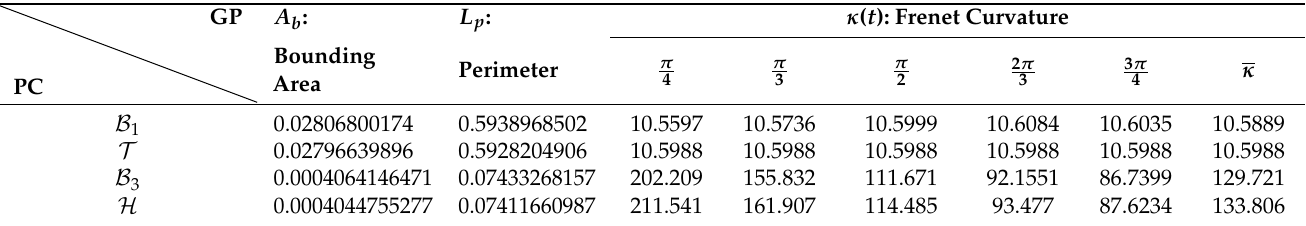
Table 1. Geometric characteristics of Plane Curves B i , T and H